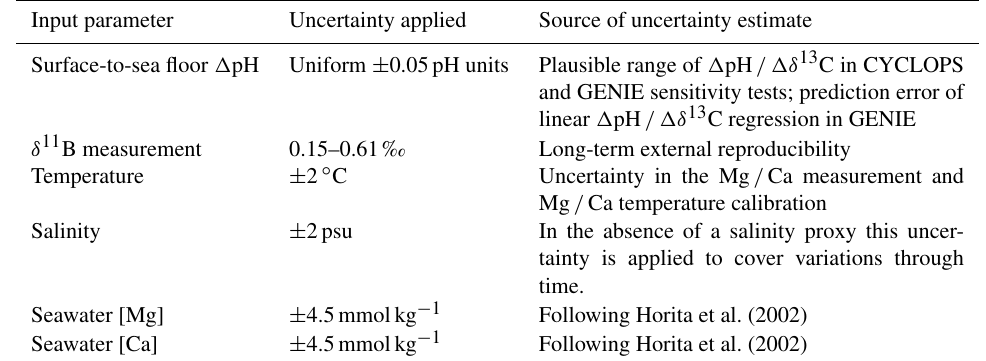
Table 2. Uncertainty inputs into the Monte Carlo simulations to calculate δ 11 B. The sources of uncertainty are also added. All uncertainty estimates are 2 σ